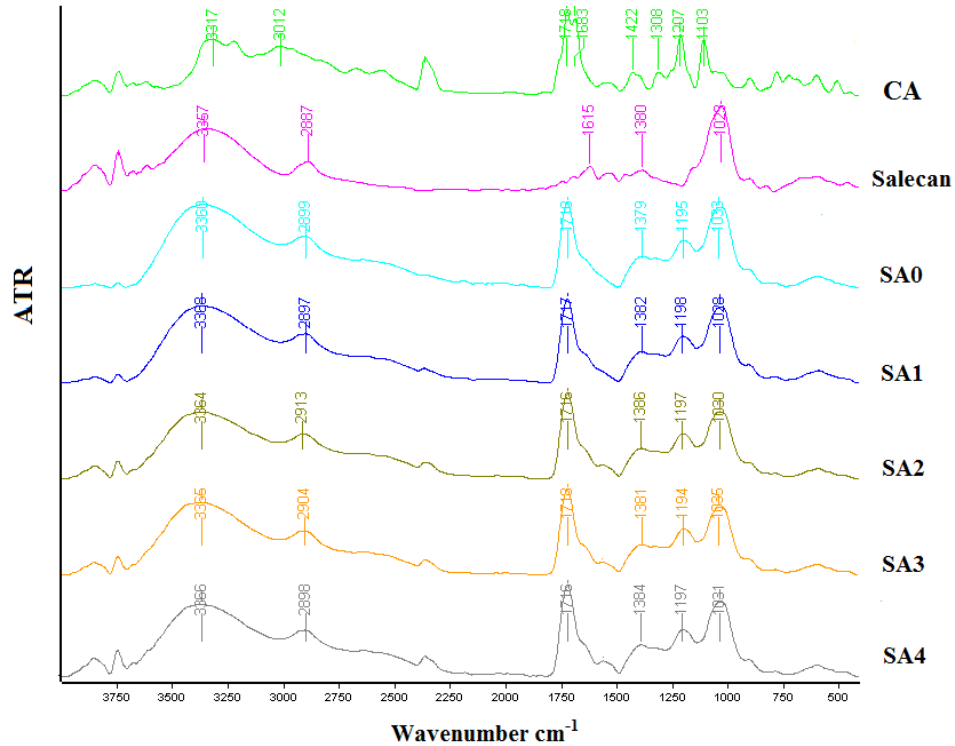
Figure 3. The FT-IR spectra of the obtained crosslinked hydrogels, salecan and citric acid. After the addition of the silver nanoparticles, the morphology of the samples remained the same, with all of them exhibiting a highly porous structure with a lamellar shape highly beneficial for medical applications